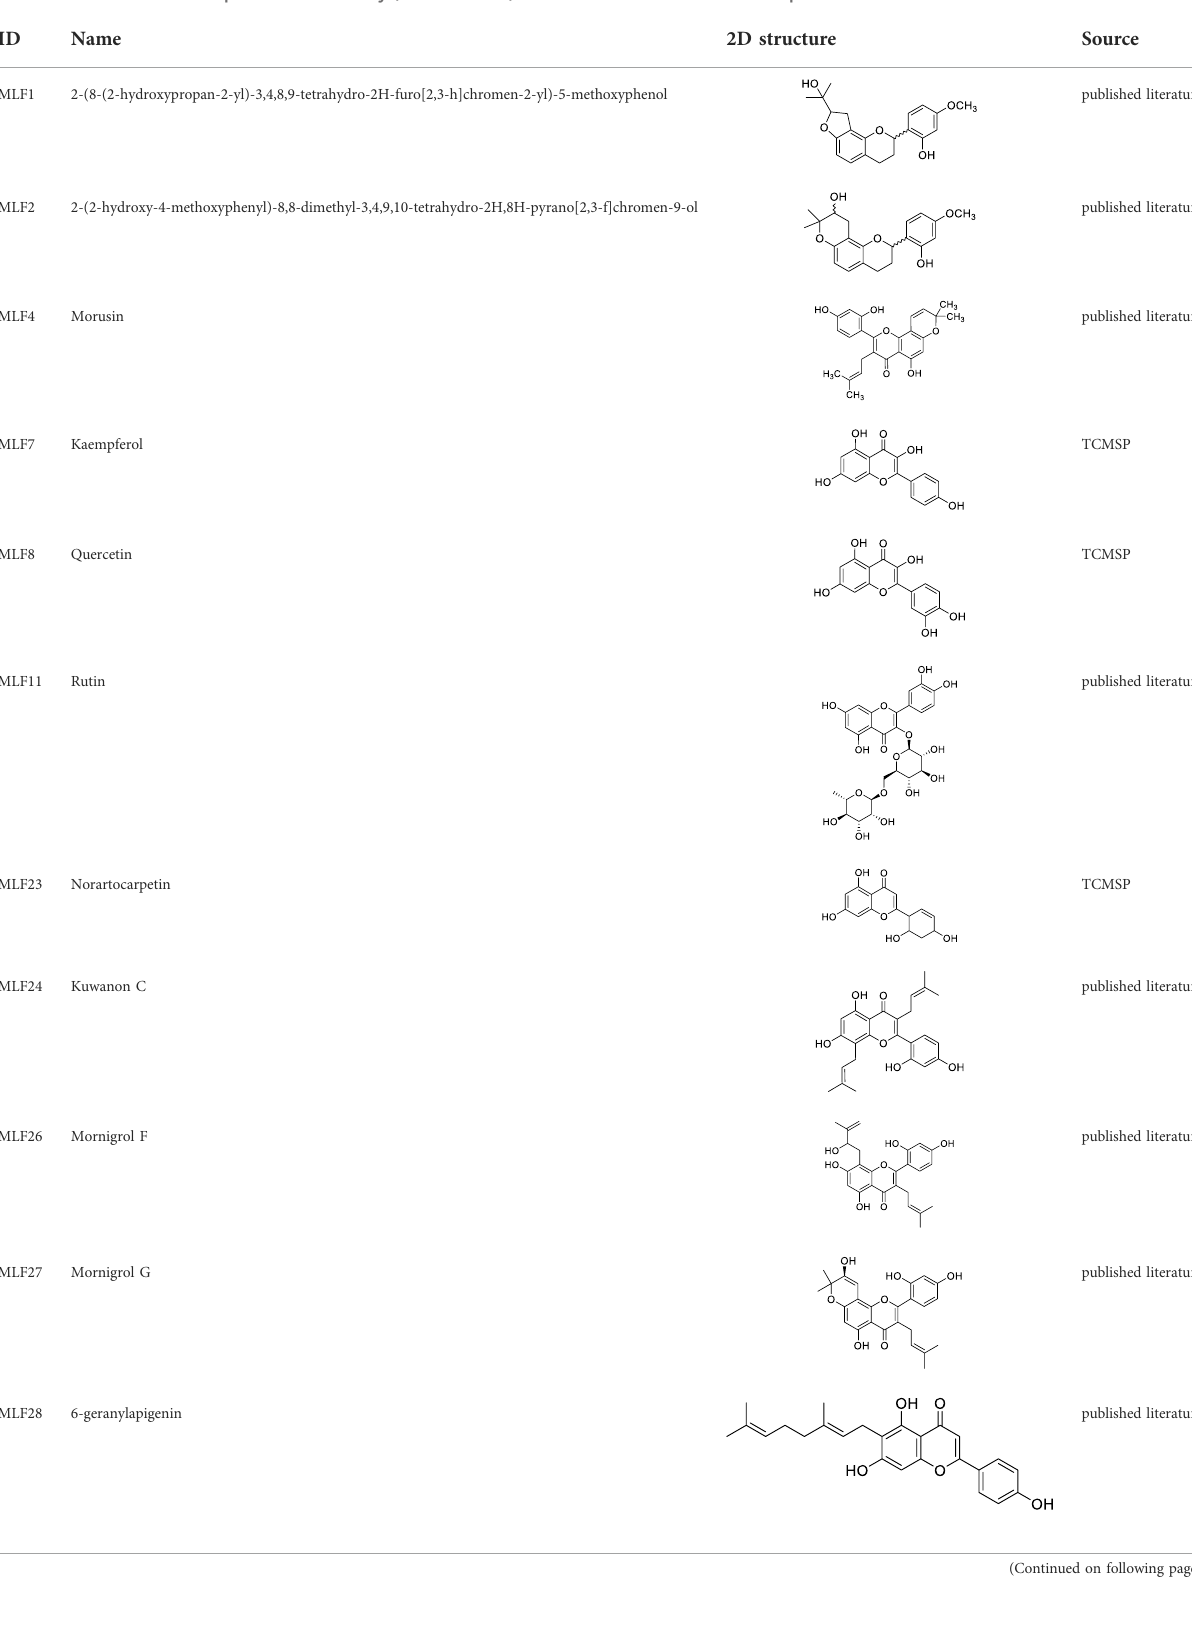
TABLE 2 The 29 active compounds of mulberry ( Morus alba L.) leaf fl avonoids and 4 active compounds of Ramulus Mori